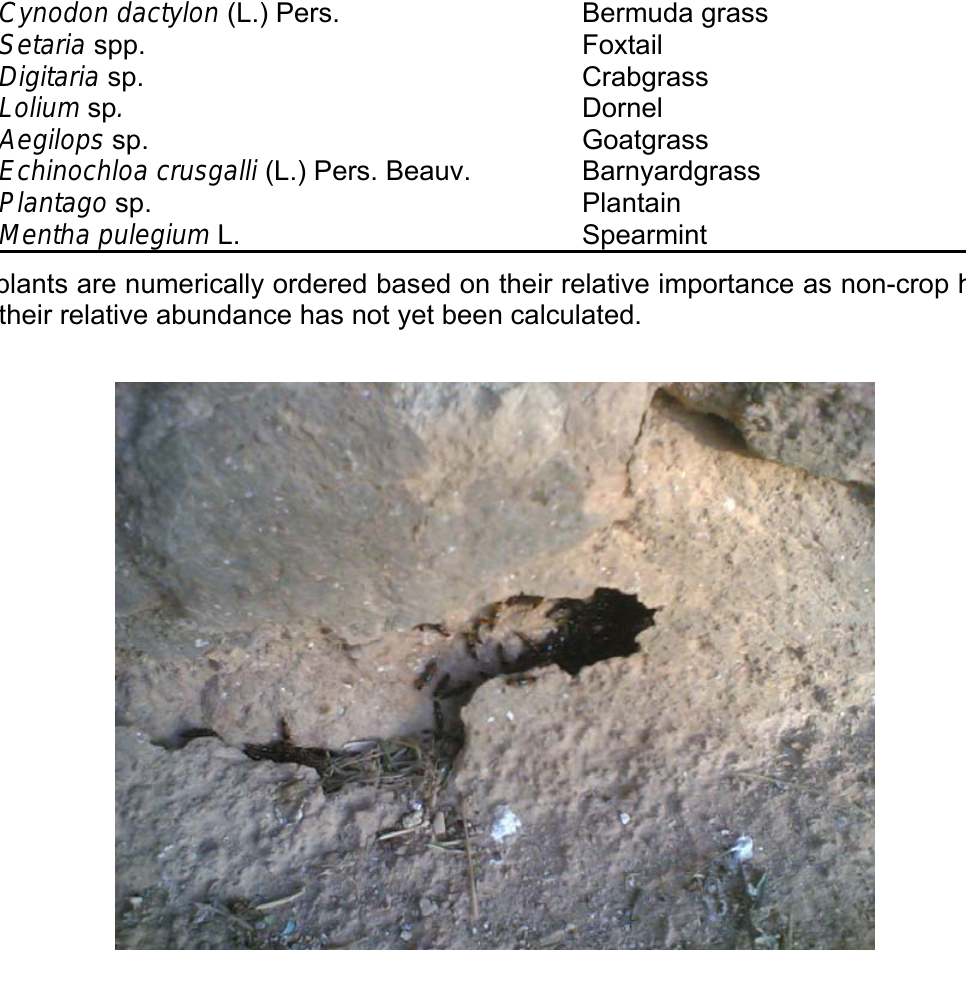
Figure 5. Soil cracks, an ideal place for adult individuals of Paederus genus, (Fars province, southern